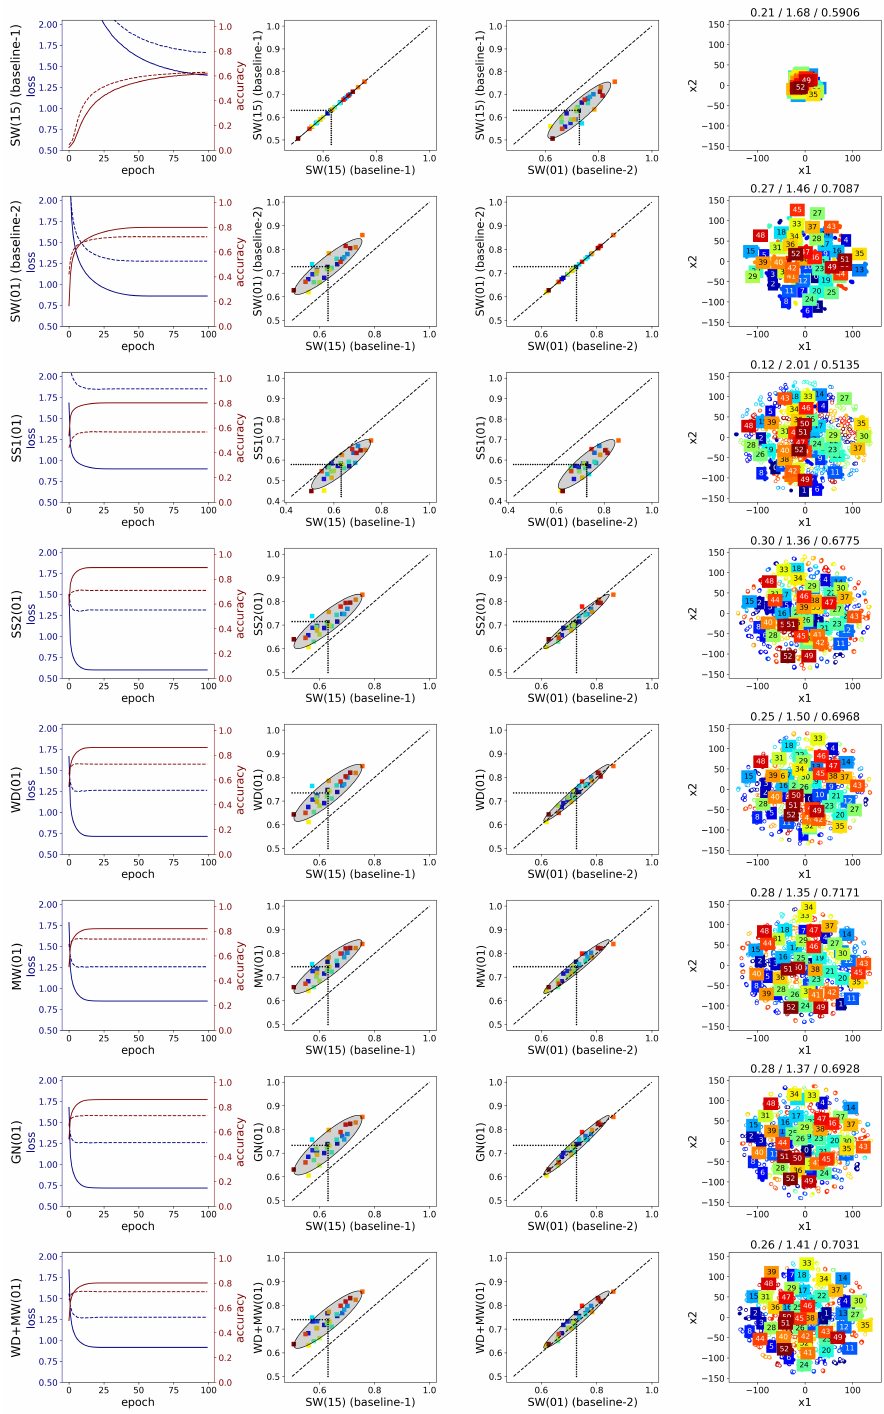
Figure A6. Average loss and accuracy graphs ( left ), augmentation vs. baseline-1 and baseline-2 accuracy per subject ( middle ), and t-SNE embeddings of a single subject ( right ) for the different augmentation methods on Ninapro-DB1. The investigated method is shown on the left of the figure. In the left plot, the solid lines correspond to training, while the dashed lines to testing. In the middle plots, color points correspond to different subjects and the ellipse shows the general shape of the points. In the t-SNE visualizations, color points correspond to different gestures, while the values at the title are the SC/DB/accuracy